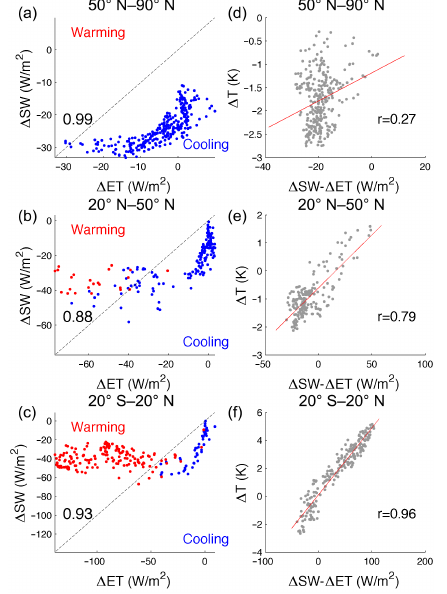
Figure 5. Changes in ET ( (cid:49) ET), absorbed shortwave radiation ( (cid:49) SW), and their relationship with temperature change ( (cid:49) T) over deforestation areas. Panels (a–c) : deforested points with their (cid:49) SW, (cid:49) ET, and the sign of (cid:49) T. The upper left area represents ET warm- ing exceeding albedo cooling; the lower-right area represents albedo cooling exceeding ET warming. Blue (red) are the actual grid points where temperature decreased (increased). Number denotes the per- centage of deforested points whose sign of (cid:49) T can be explained by the relative importance of (cid:49) SW and (cid:49) ET. Panels (d–f) : spatial relationship between (cid:49) SW − (cid:49) ET and the amplitude of (cid:49) T. Red line is the regression line, and r is the correlation coefficient. Panels (a, d) : boreal deforestation; panels (b, e) : northern temperate defor- estation; panels (c, f) : tropical deforestation.